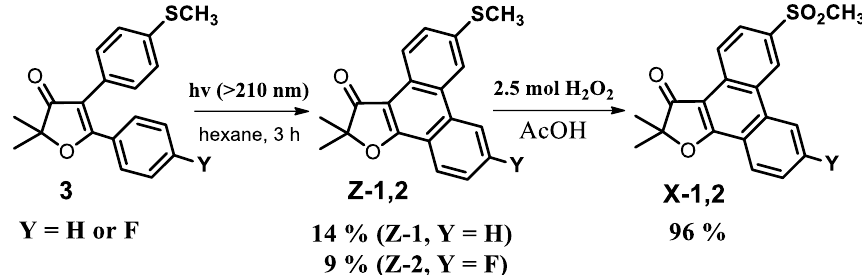
p -F H a In brackets, the yield of both 1,2-migration products and their ratio are given. b As a percentage of the total weight of the mixture 3 .